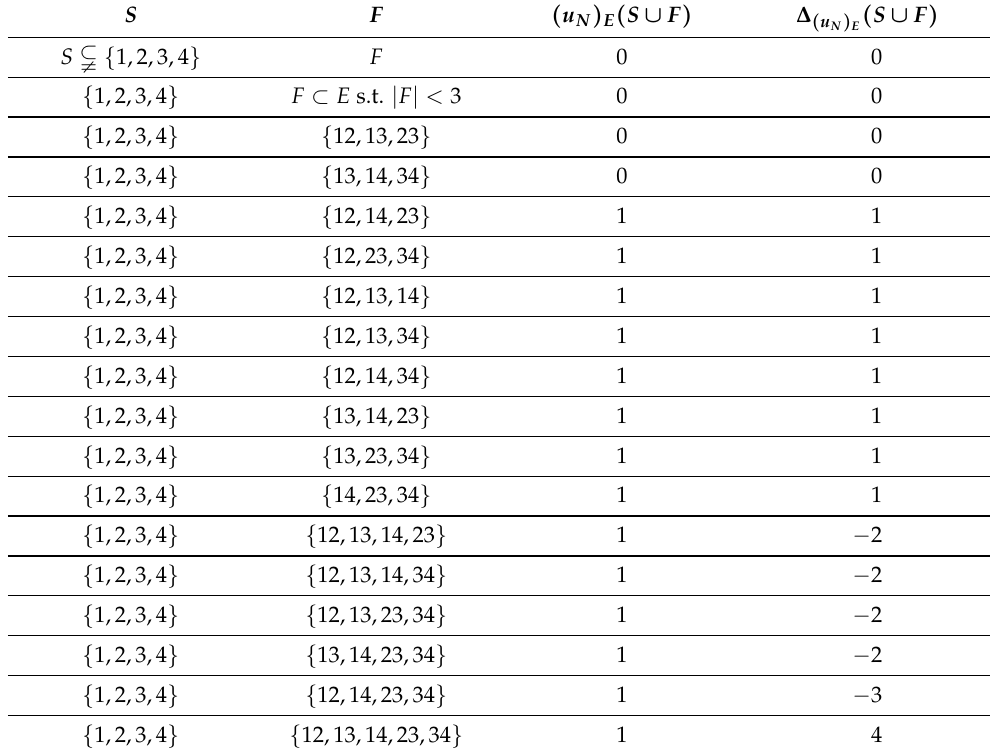
Table 1. Technical game ( u N ) E and dividends.